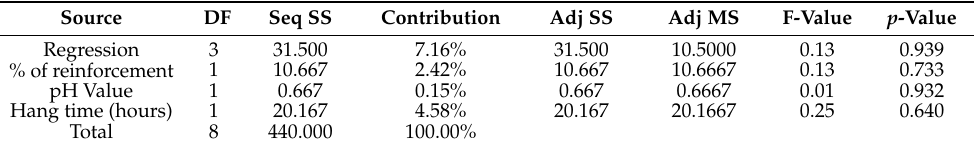
Table 21. Analysis of variance for microhardness.